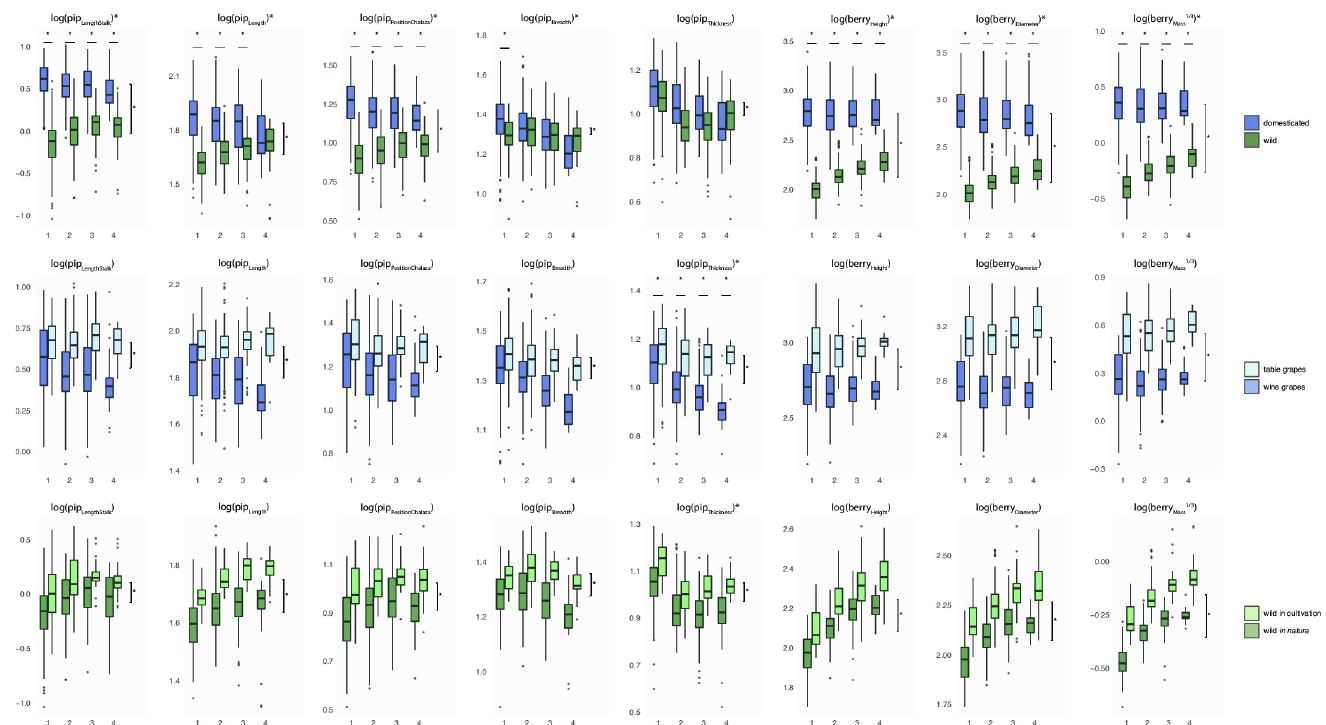
Fig 2. Comparisons of (logged) lengths and (log cubic-rooted) mass measurements. Each row represents a different comparison: a) wild and domesticated grapevines, b) table and wine varieties for domesticated accessions only, and c) cultivated and collected from wild for wild grapevine only. For each measurement, boxplots are displayed for each piposity level. Differences are tested using multivariate analyses of covariances, and differences of P < 10 − 5 , are indicated by stars in the facet title (interaction), on the right (overall difference) and above each piposity level (difference within a given piposity).